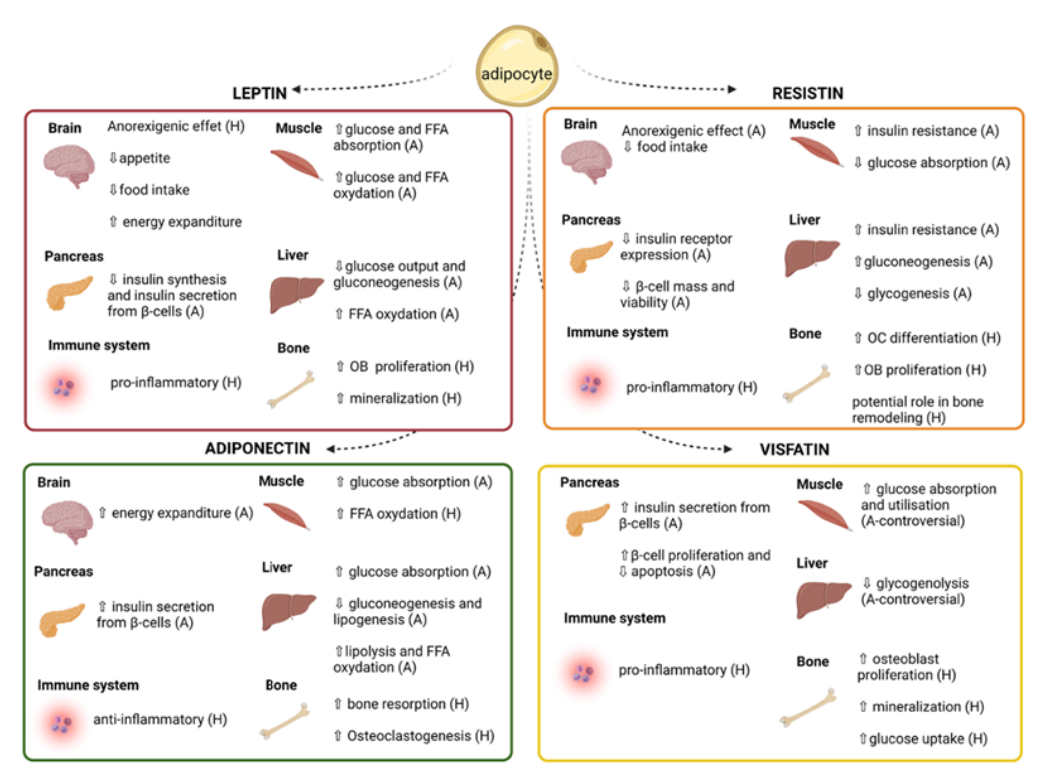
Figure 1. Roles of adipokines on peripheral organs. Leptin, adiponectin, resistin, and visfatin are hormones secreted by the adipose tissue that impact energy metabolism, inflammatory processes, and bone health via their actions on peripheral organs. FFA: Free fatty acid; OB: Osteoblasts; A: Animal studies; H: Human studies. This figure was created using BioRender.com.